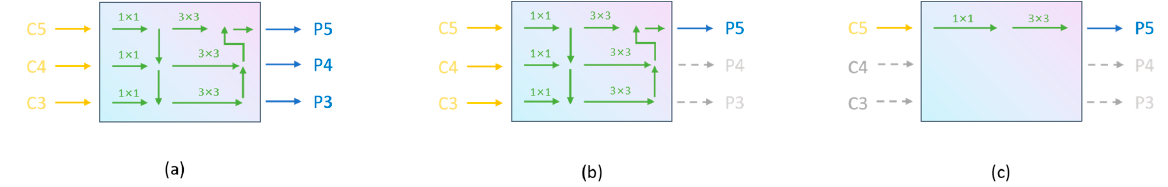
Figure 4. ( a ) Traditional feature pyramid multiple-in-multiple-out structure, ( b ) multiple-in-single- out structure, ( c ) single-in-single-out structure in this method. out structure, ( c ) single-in-single-out structure in this